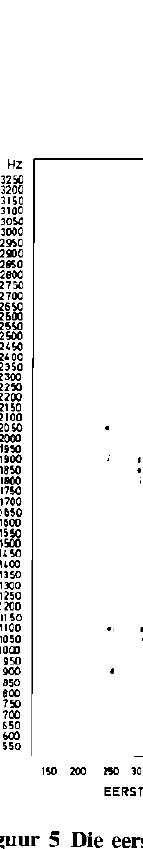
Figuur 5 Die eerste- en tweedeformantfrekwensies van vokale geproduseer deur dowes kansige blokontwerp as variansieanalisetegniek gebruik is, naam- lik Scheffe se paarsgewyse vergelykingstegniek (Steyn et al., 1984). Geeneen van die gehoorgestremde groepe se gemiddelde eerste- formantfrekwensie is dus vergelykbaar met die van die normaal- horendes nie, en verder verskil hulle ook